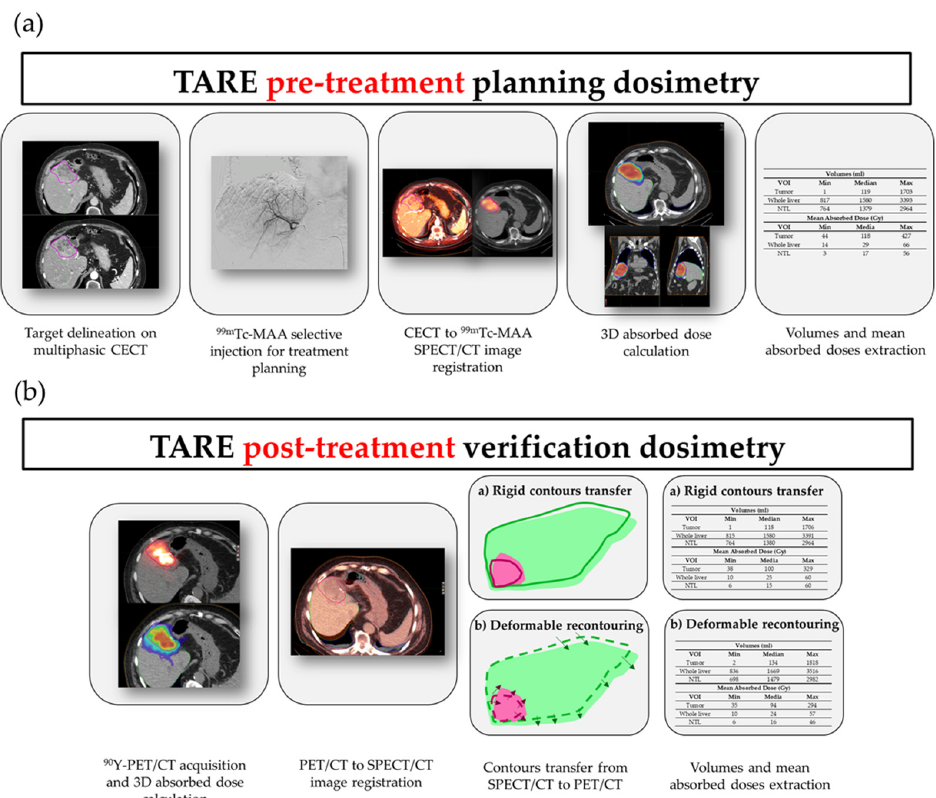
Figure 1. TARE pre-treatment planning dosimetry (panel ( a )) and post-treatment verification dosimetry (panel ( b )) workflows.